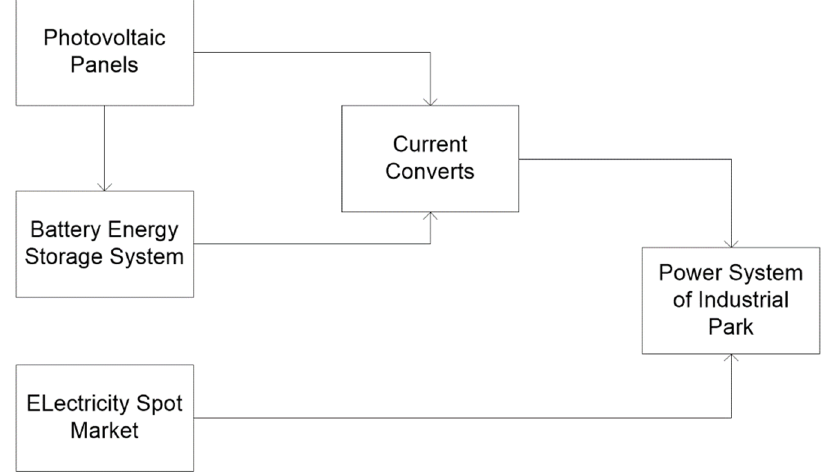
Figure 2. ESS System Structure of the Industrial Park.